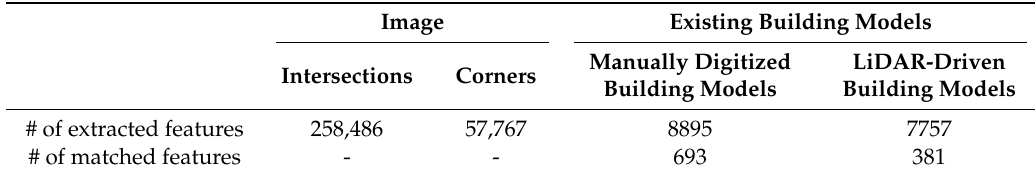
Figure 9. Edged corner features from image: ( a ) straight lines (red) and ( b ) edged corner features (blue). Table 2. Extracted features and matched features for the Toronto dataset.